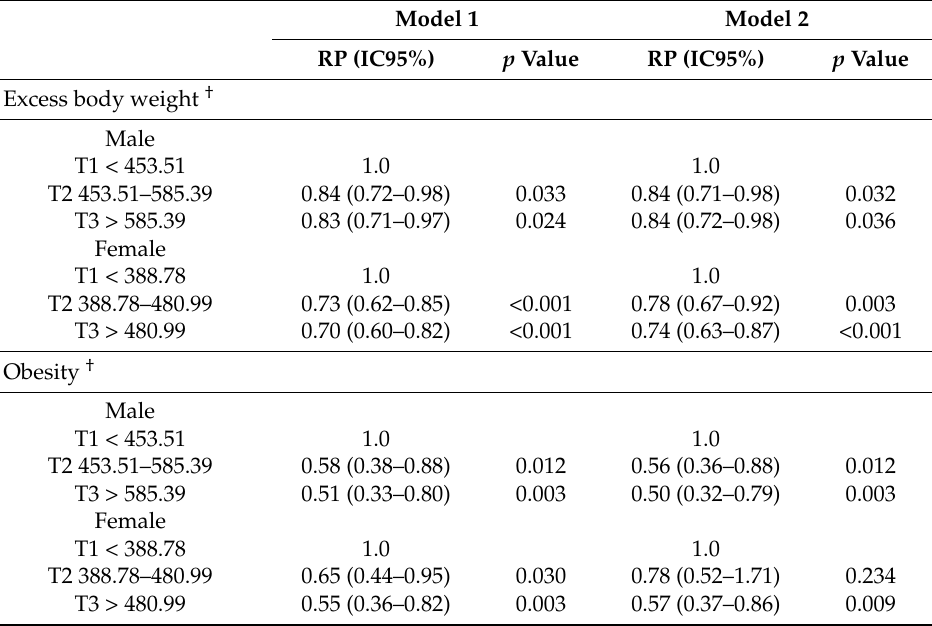
Table 4. Prevalence ratio (PR) or odds ratio (OR) for excess body weight * and obesity ** for males and females according to tertiles of folate intake ( µ g/d) of the CUME project participants ( n =